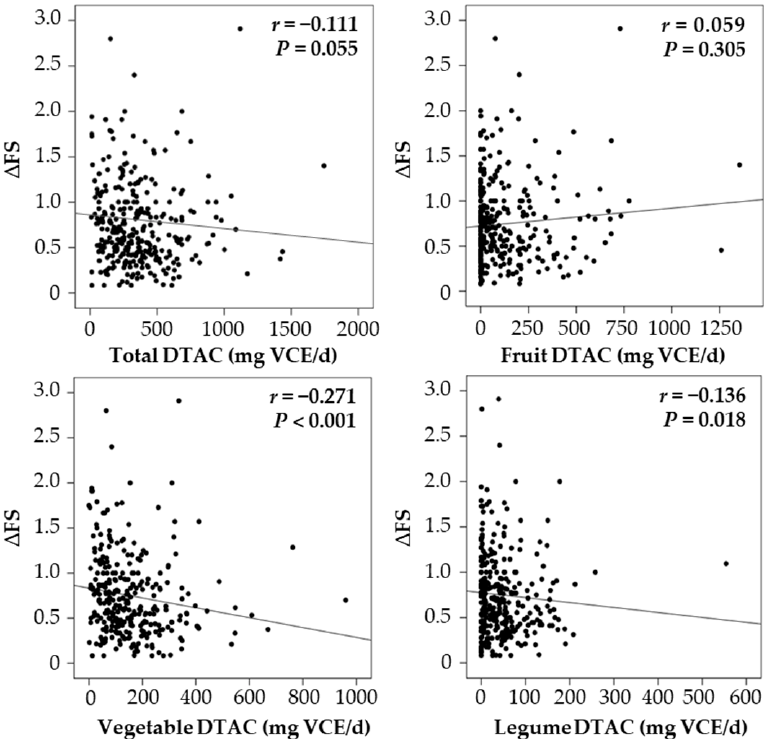
Figure 2. Association between dietary total antioxidant capacity (DTAC) and disease progression rate ( ∆ FS). The correlation between DTAC and ∆ FS was determined by Spearman’s rank correlation coefficients.